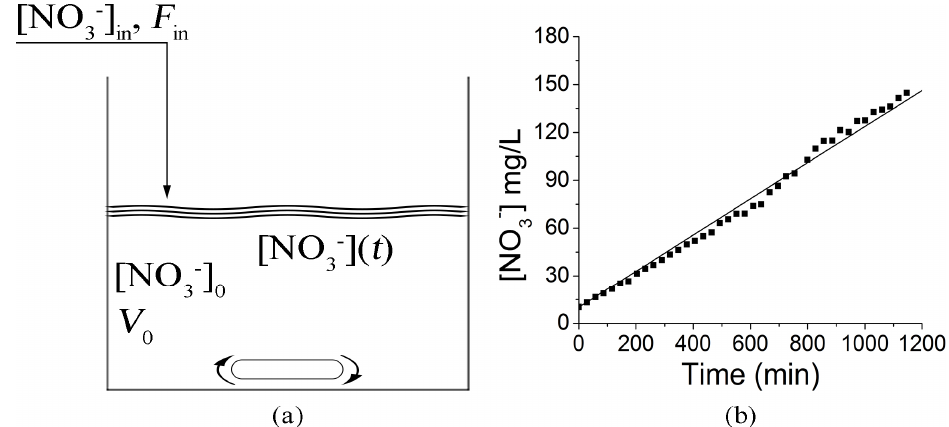
Figure 2. ( a ) Sketch of the Semi-batch reactor used for the experimental setup tests; ( b ) Comparison between the experimental data (black squares) and the theoretical curve (black line) of [NO 3 − ]( t ) in a semi-batch reactor where V 0 = 250 mL, [NO 3 − ] 0 = 10 mg/L, [NO 3 − ] in = 13.6 g/L and F in = 2.11 μ